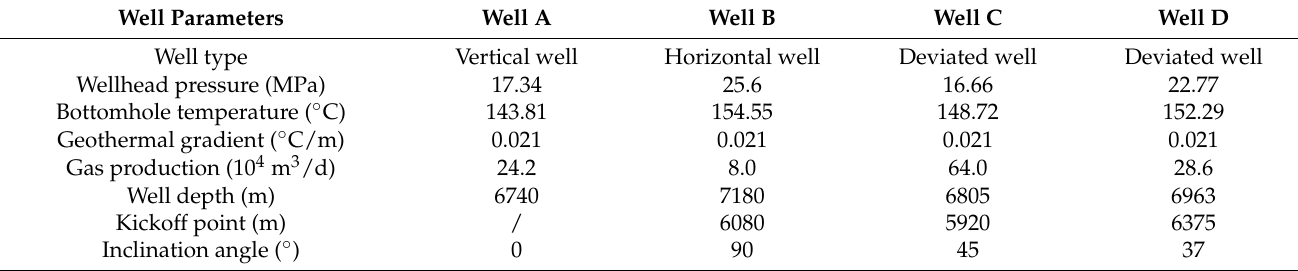
Table 4. Basic gas-well parameters.